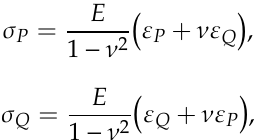
Table 2. Main error sources in strain gauges measurement technique [17].